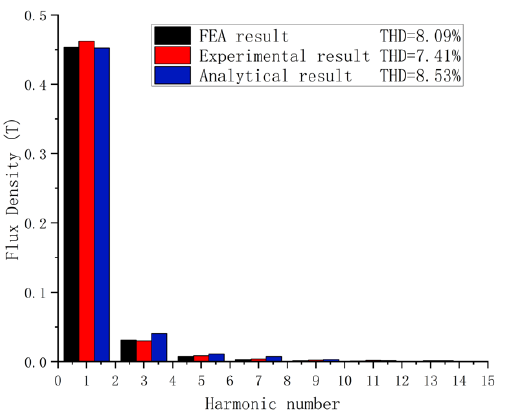
Figure 11. Comparison of the waveforms of the analytical result, FE result and experimental re- sult.